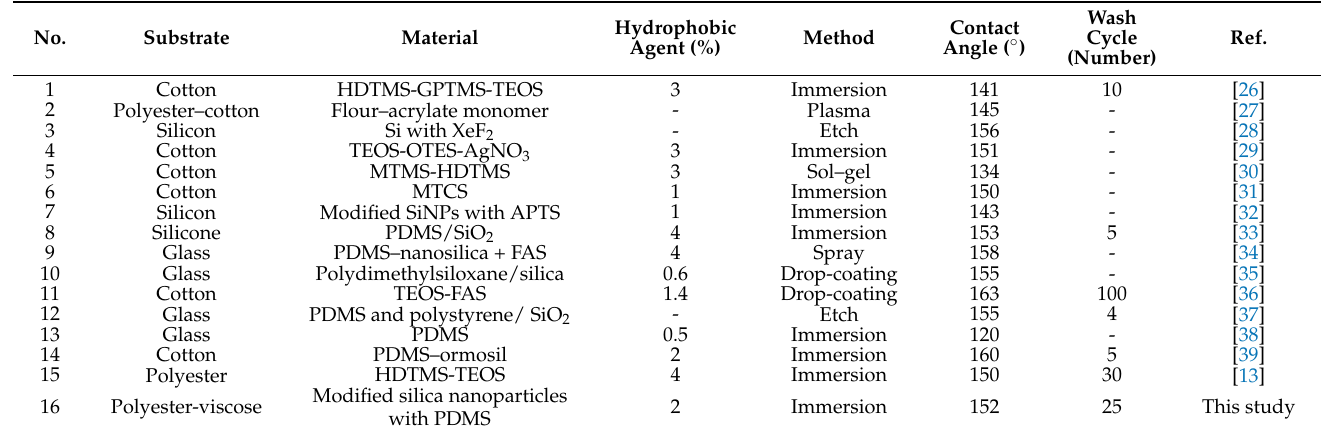
Table 1. Comparison of hydrophobicity of different substrates using various approaches.